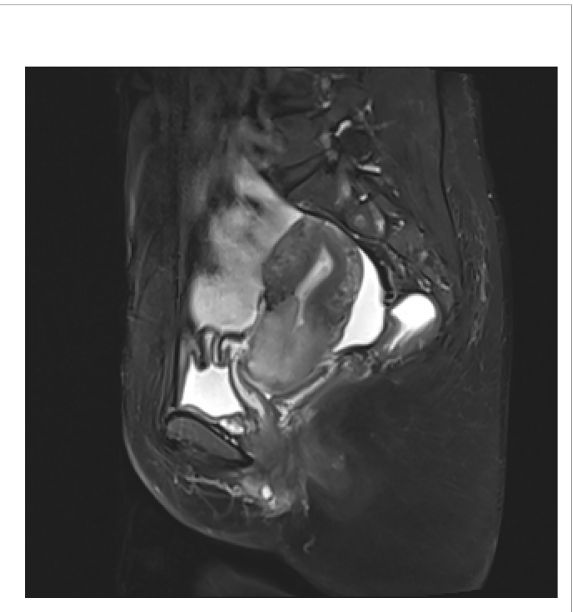
FIGURE 1 Pelvic magnetic resonance imaging (MRI) showed a cervical tumor 40 mm * 36 mm * 48 mm in size, without invasion of the uterus and vagina, and no pelvic lymph node